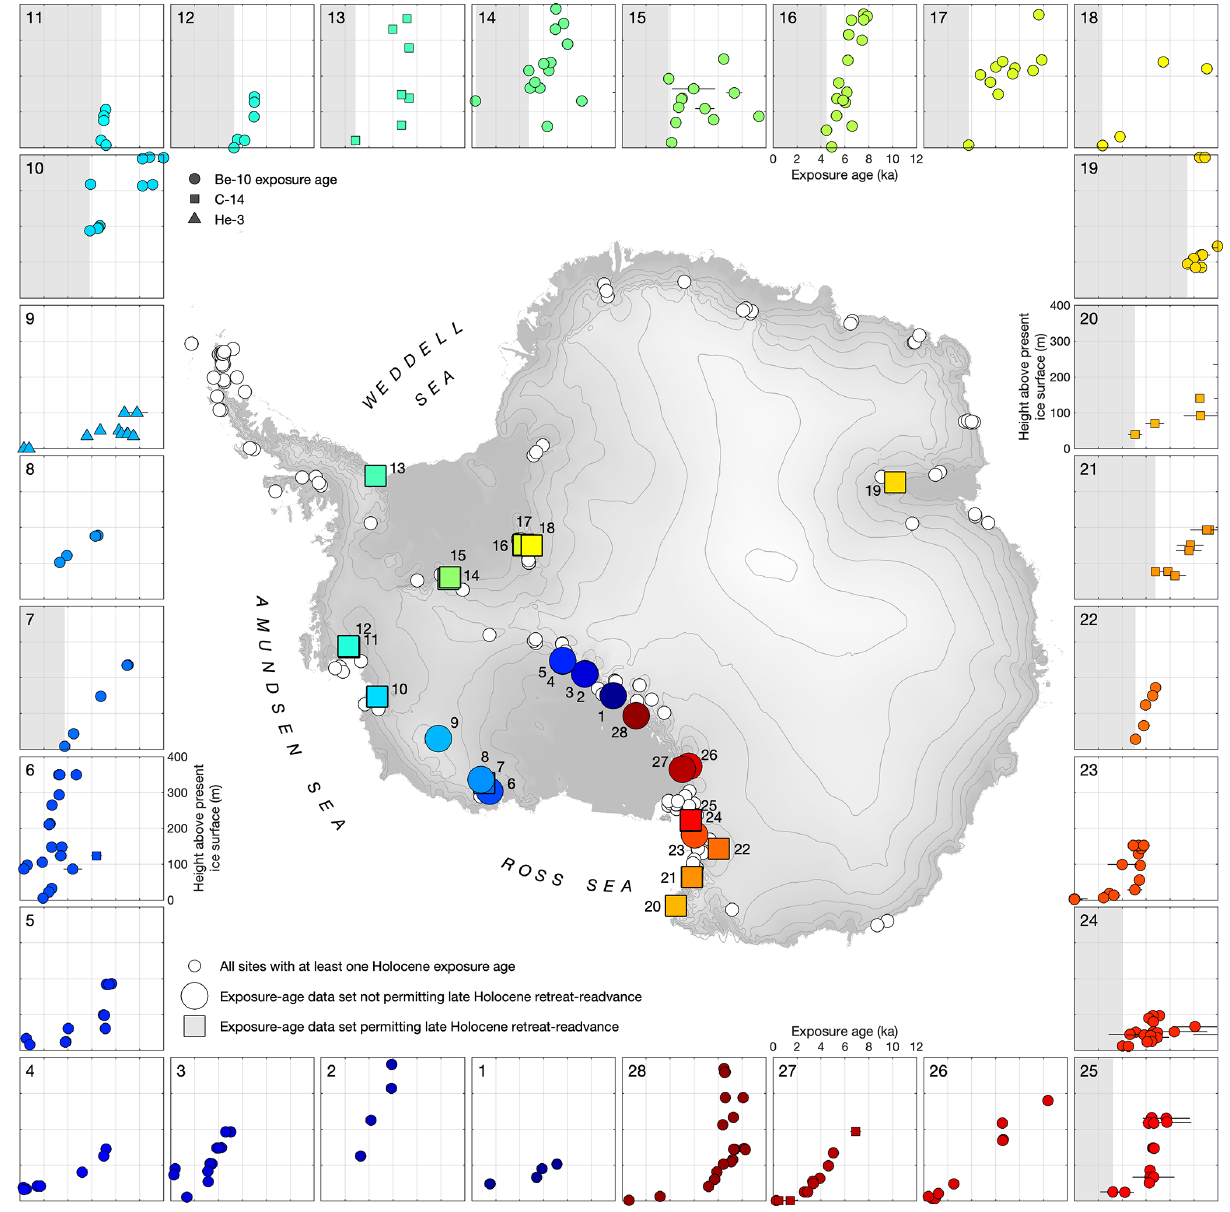
Figure 2. Evidence from Holocene exposure age data collected from various locations in Antarctica that do or do not permit ice sur- face lowering below the present elevation during the late Holocene. The figure was generated from the ICE-D ANTARCTICA: informal cosmogenic-nuclide exposure-age database (ICE-D ANTARCTICA, 2022). There are many sites (230) which have at least one Holocene exposure age (small white circles). This figure shows only a subset of those sites or groups of sites that have more than four Holocene data which together display a reasonably coherent thinning history. Sites where the lowest data are at or near sea level are also excluded because thinning below sea level is unfeasible and could not be recorded by exposure age data anyway. The sites are classified by whether they do (squares on map, grey shading on axes highlighting age gap) or do not (circles, no shading) have a late Holocene gap where readvance could have occurred. For purposes of this figure, a late Holocene gap is deemed to exist if the age–elevation trend defined by the exposure age data intersects the present ice surface before the present